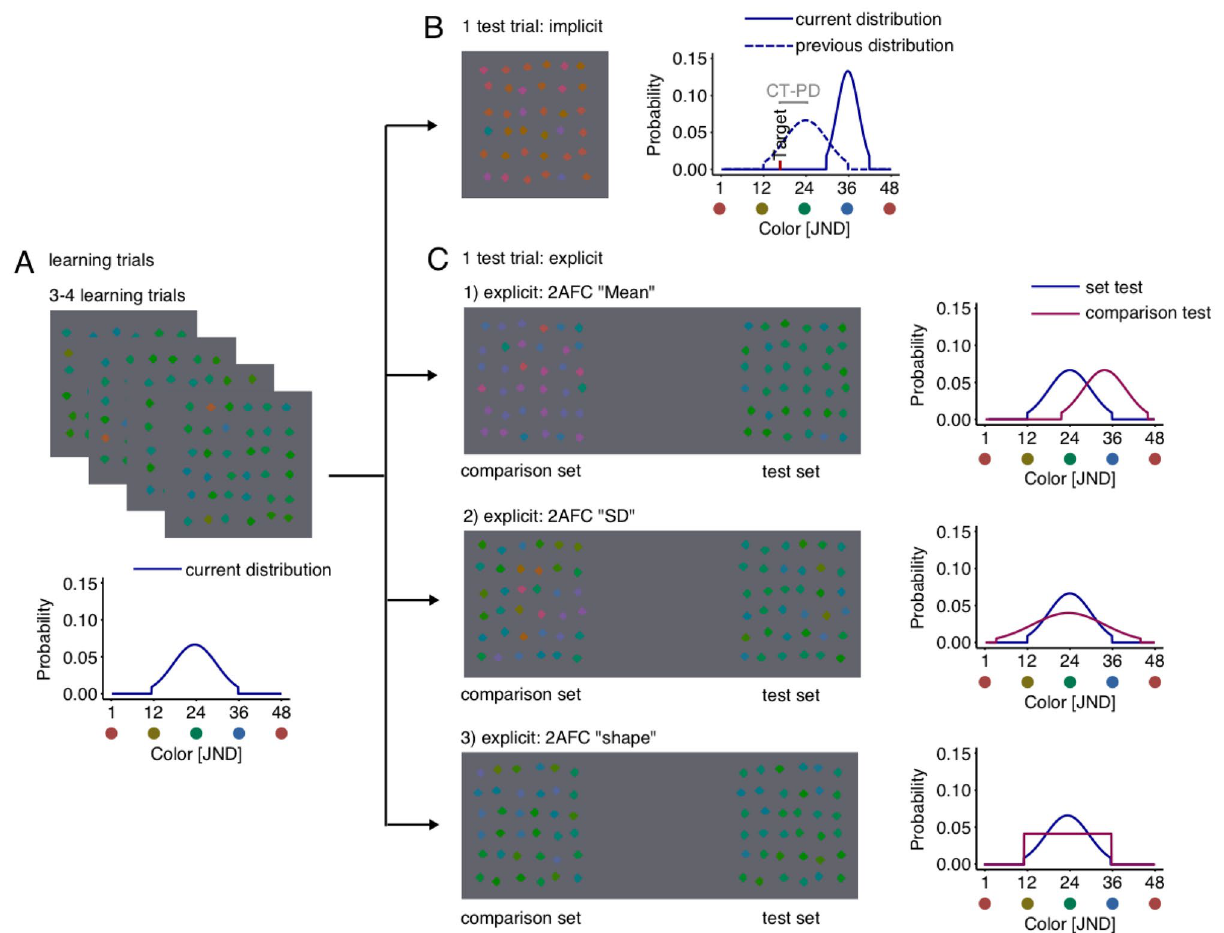
Figure 3. Overview of the experimental procedure. All conditions contained blocks that started with ( A ) learning trials. Learning trials consisted of 3–4 search trials where observers searched for the oddly-colored diamond and reported the location of the cut-off corner. Colors on each learning trial within block were drawn from the same Gaussian distribution but differed between blocks. Implicit learning trials were followed by a test trial ( B ). Here, observers performed another search trial where targets were placed at quasi-randomly chosen probe points around the previous distractor distribution. Explicit learning trials were followed by a ( C ) test trial where observers were presented with two sets of distractors. The colors in the test set were drawn from the same distribution as for the learning trials. The colors of the comparison set were drawn from distributions that differed in mean, SD or distribution